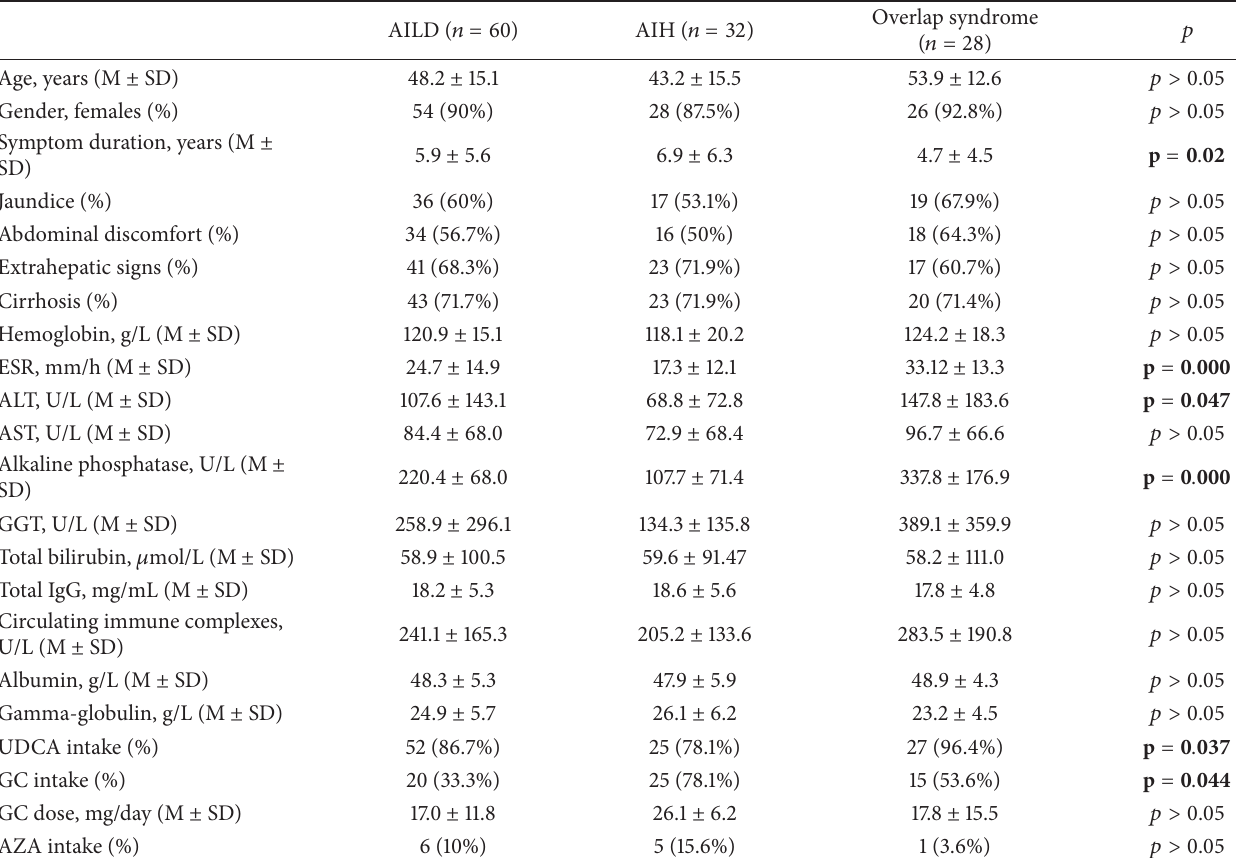
Table 1: Patients’